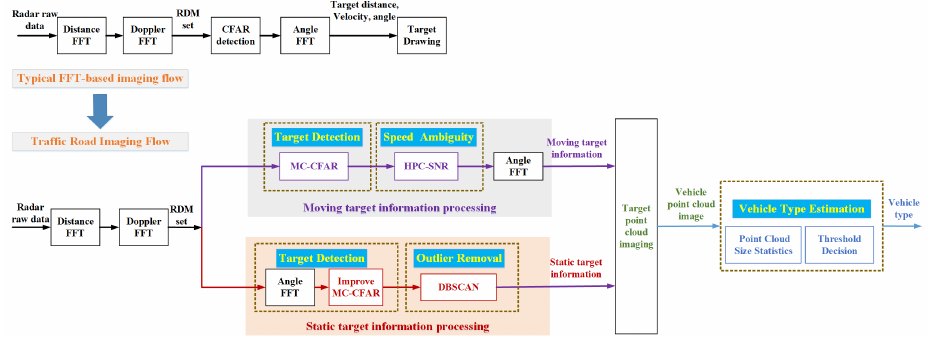
Figure 9. The improved 3D-FFT radar imaging